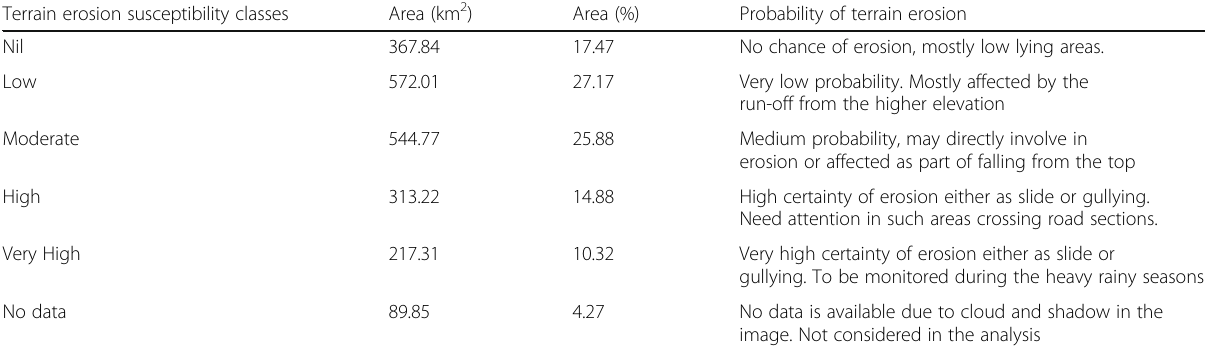
Table 2 Terrain erosion susceptibility classes derived from the reclassification of TESI Terrain erosion susceptibility classes